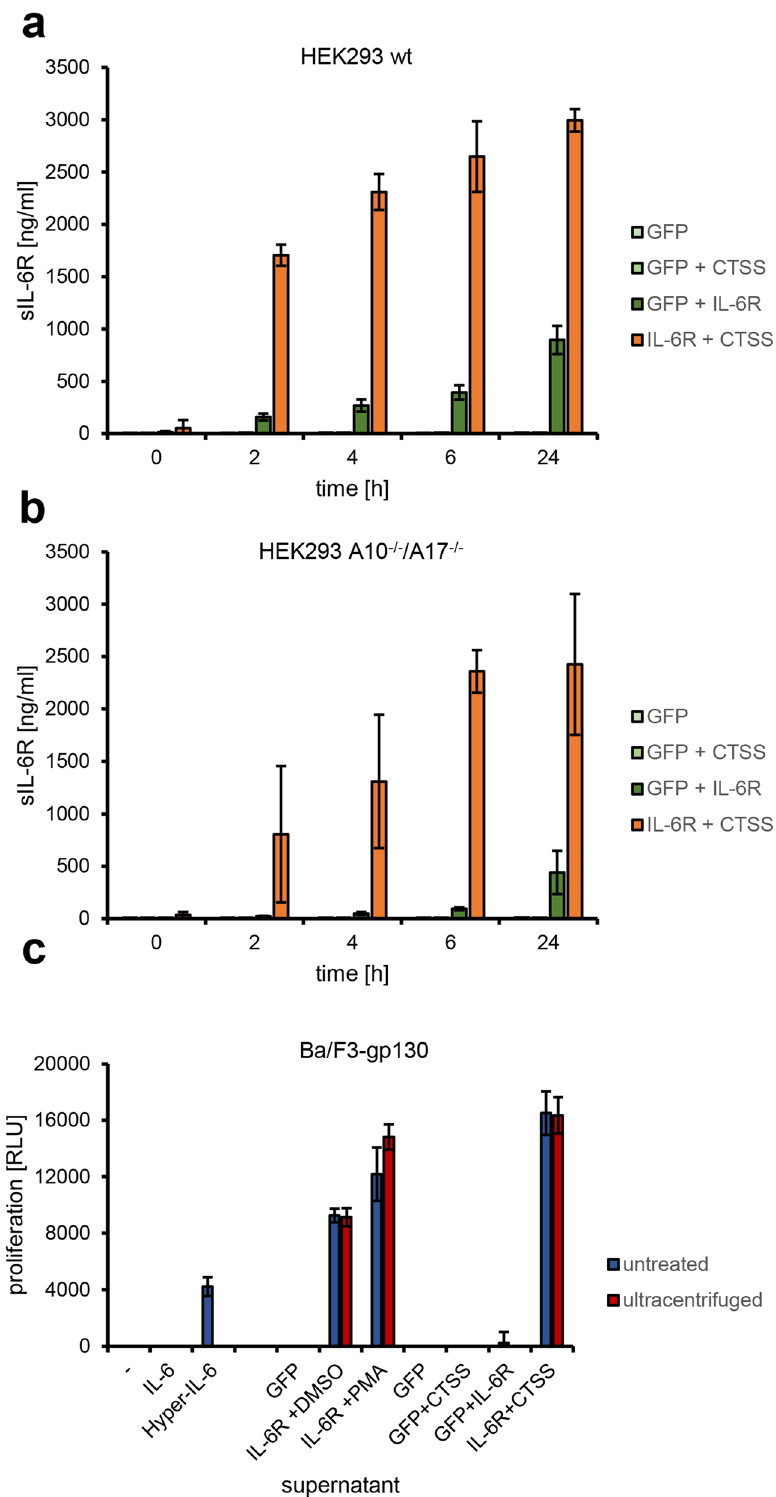
Figure 4. Cathepsin S generates a biologically active sIL-6R independent of ADAM10 and ADAM17. (a) HEK293 cells were transiently transfected with expression plasmids encoding GFP and CTSS, GFP and IL-6R, IL-6R and CTSS or only with an expression plasmid encoding GFP. The medium was exchanged 24 h after transfection and the conditioned medium harvested after different periods of time (0–24 h). The amount of sIL-6R in the medium was determined by ELISA (mean ± SD). (b) The experiment was performed as described for panel ( a ), but HEK293-ADAM10 −/− /ADAM17 −/− cells were used instead. (c) In order to investigate whether the sIL-6R generated by CTSS was biologically active, equal amounts of Ba/F3-gp130 cells were stimulated with recombinant proteins and/or supernatants as indicated. Cell proliferation as measured by cell viability was determined 48 h later. Red colored bars indicate supernatant after ultracentrifugation, whereas the blue bars indicate supernatant without